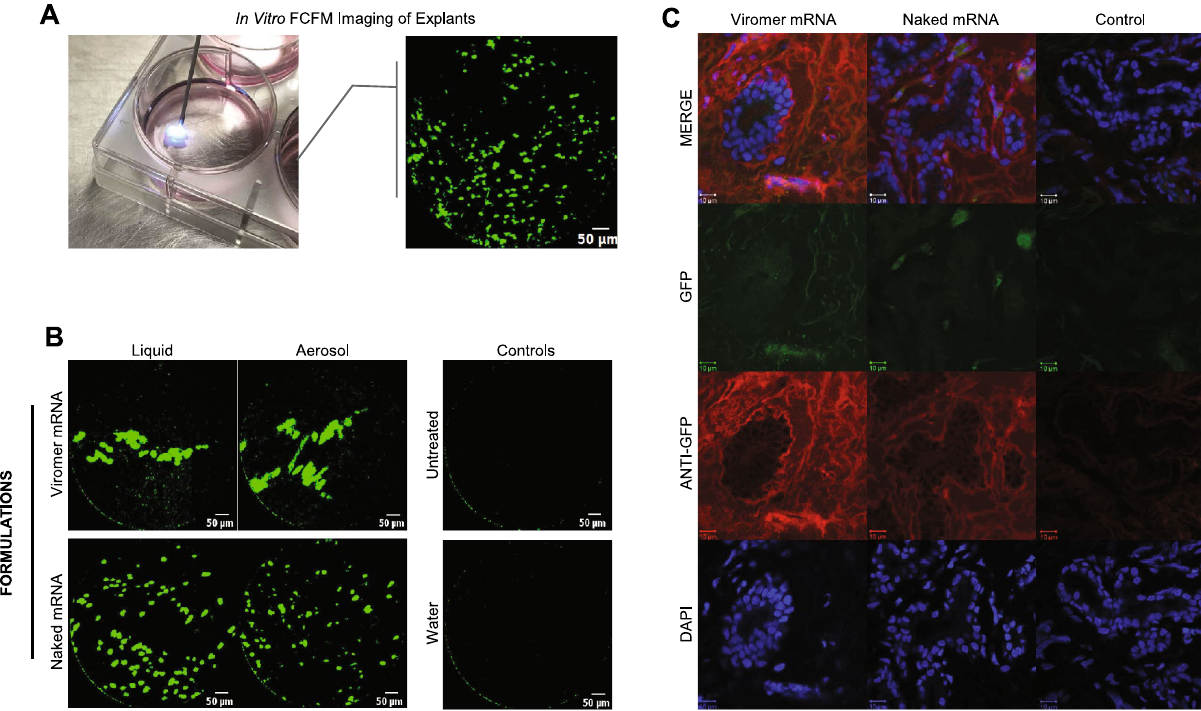
Figure 2. Expression of eGFP in transfected bronchial explants was achieved with naked mRNA and Viromer mRNA as detected by fiberoptic confocal fluorescent endomicroscopy (FCFM) imaging and immunohistochemistry. Cultured bronchial explants were transfected with 0.8 µg eGFP mRNA, delivered in either water or Viromer, with culture media temporarily removed. FCFM imaging in the 488 nm excitation channel was performed 24 h after transfection of the cultured bronchial explants. (A) Continuous 1-min video recordings were recorded of each explant. (B) Representative images from FCFM demonstrating eGFP expression in all transfected explants and none in the control explants. (C) Immunohistochemistry staining of fixed samples from the same explants from (B) , stained with a polyclonal anti-GFP antibody labeled with Alexa Fluor 647, confirmed eGFP expression (green) in transfected bronchial epithelium, co-localized with the anti-GFP (red) and nuclear staining (DAPI, blue). Note that the red anti-GFP does not co-localize with the eGFP because the latter was greatly diminished by tissue fixation and because fixed tissues can produce green autofluorescence indistinguishable from GFP. The purpose of this figure is to demonstrate localization of GFP in respiratory epithelial cells, indicating successful